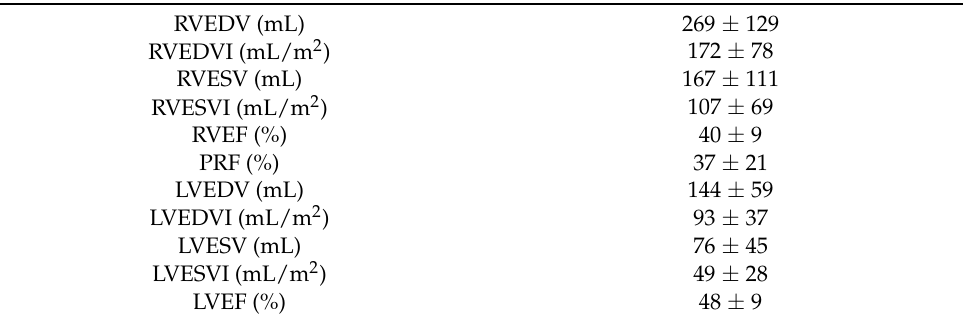
Table 4. Cardiac magnetic resonance